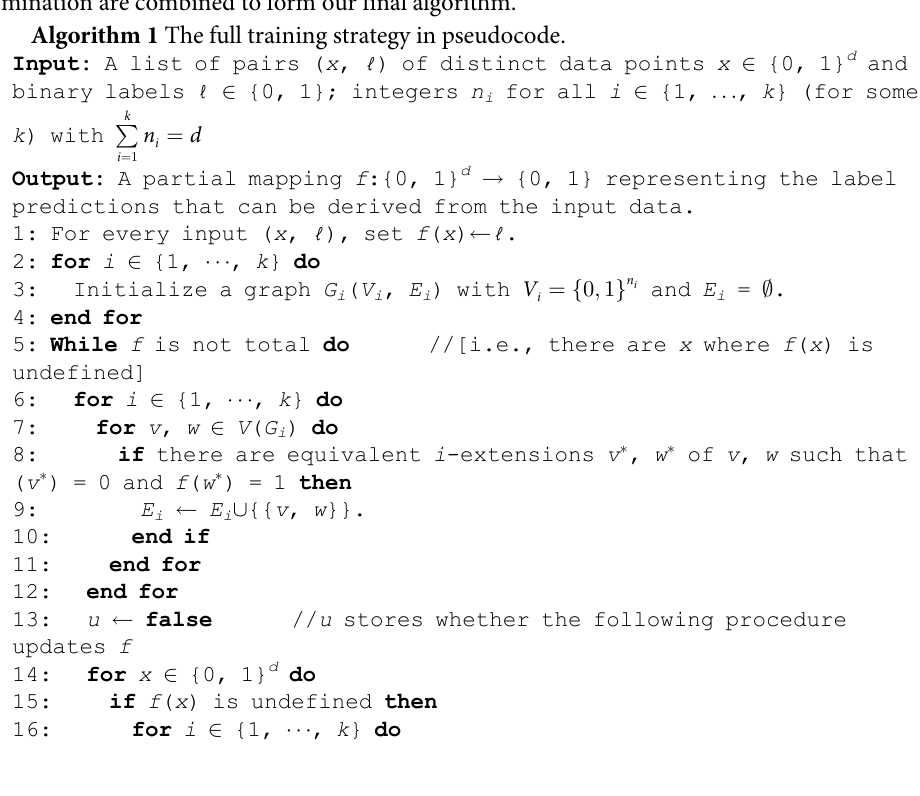
Algorithm 1 The full training strategy in pseudocode.